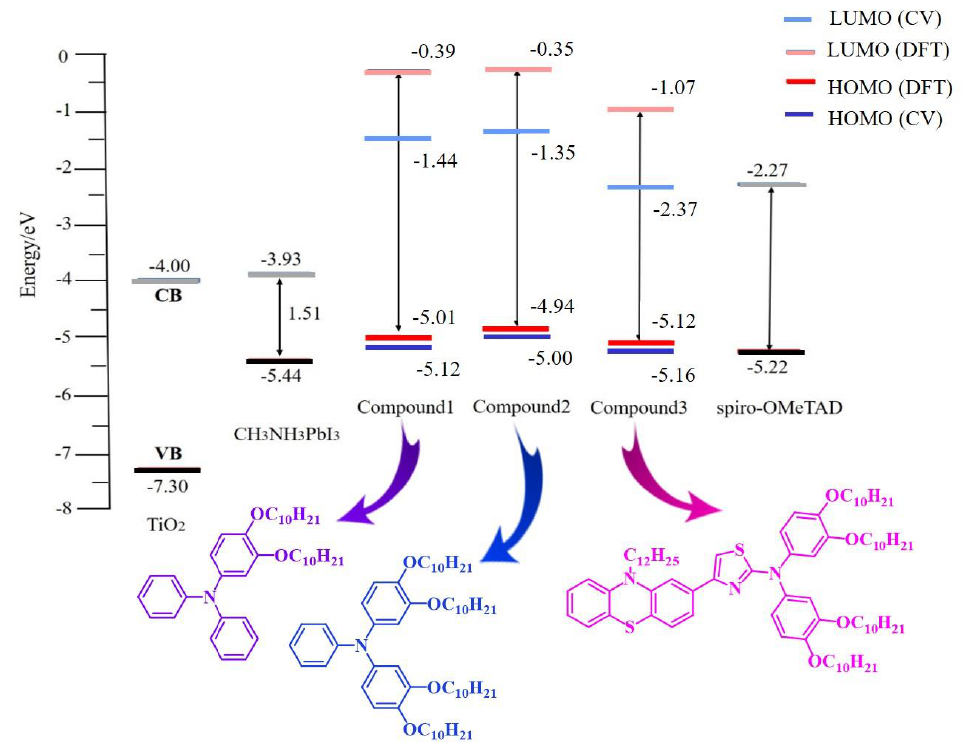
Figure 6. Energy level diagram of the investigated hole transporting materials. Table 2. Calculated energy levels of frontier molecular orbital (HOMO and LUMO), and the energy gaps Δ L-H of the three studied molecules.